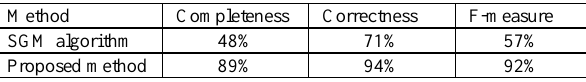
Table 4: Statistical analysis of computed disparity map by SGM algorithm and enhanced by proposed